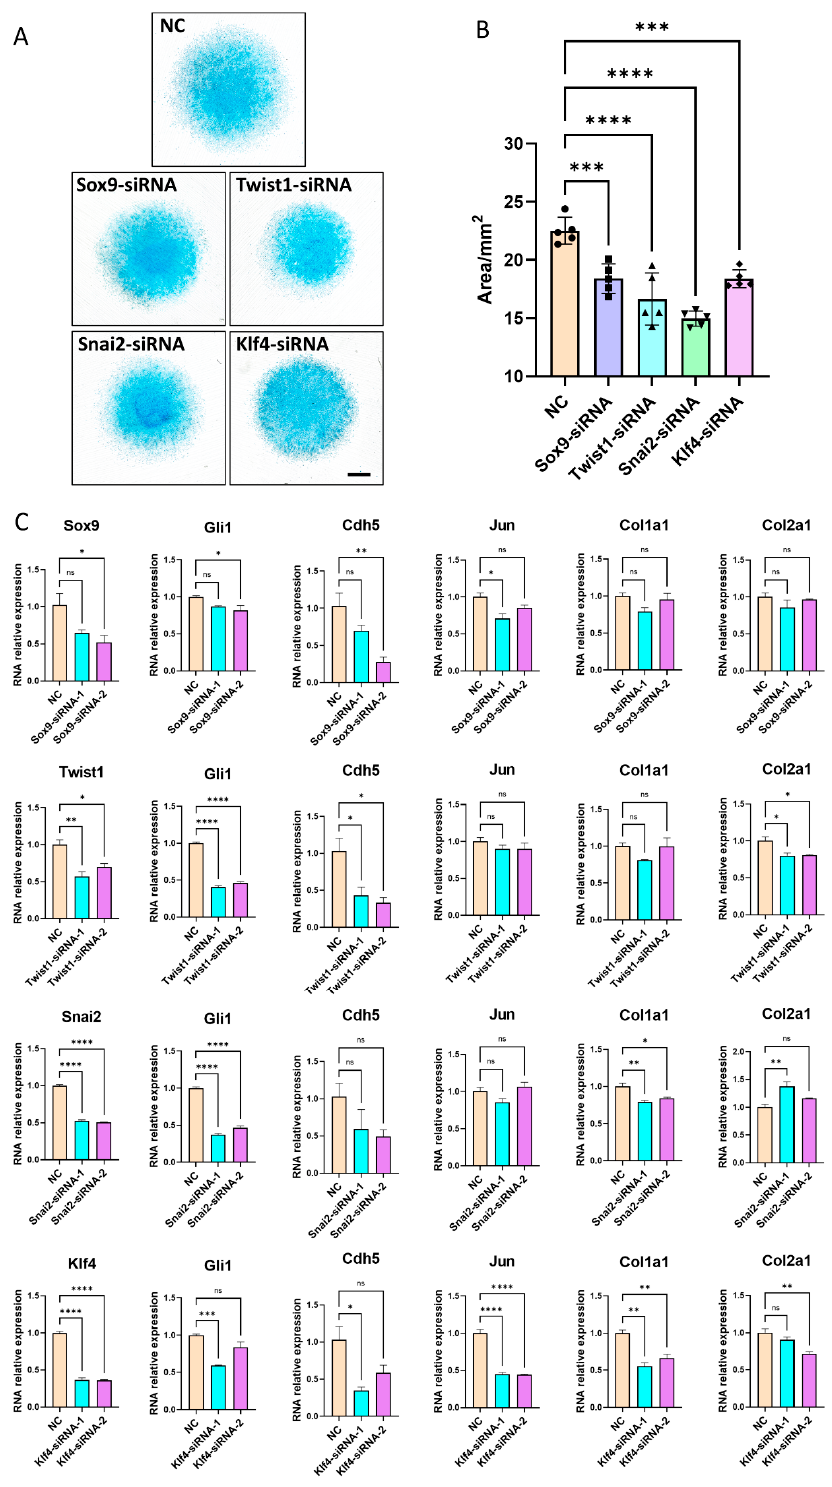
Figure 5. Inhibition of Sox9, Twist1, Snai2 and Klf4 in ATDC5 cells. ( A ) Alcian blue staining of ATDC5 cells after knockdown of transcription factor Sox9, Twist1, Snai2 and Klf4, respectively. The bar represents 1 mm. ( B ) Statistics of Alcian blue staining area. Data are presented as the mean ± SEM. ( C ) RNA relative expression of Sox9, Twist1, Snai2, Klf4, Gli1, Cdh5, Jun, Col1a1 and Col2a1 in ATDC5 cells after knockdown of four transcription factors, respectively. NC is negative control. Data are presented as the mean ± SEM. * p < 0.05; ** p < 0.01; *** p < 0.001; **** p < 0.0001; ns means no statistical